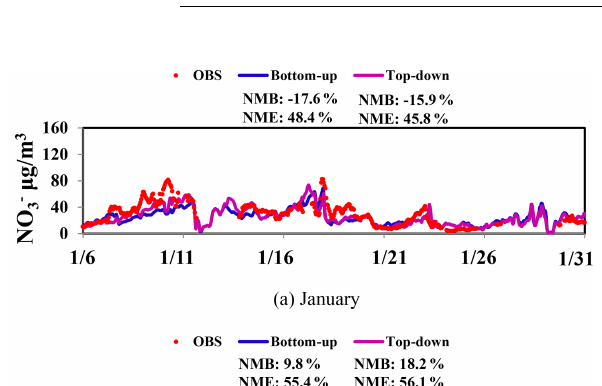
concentrations 3